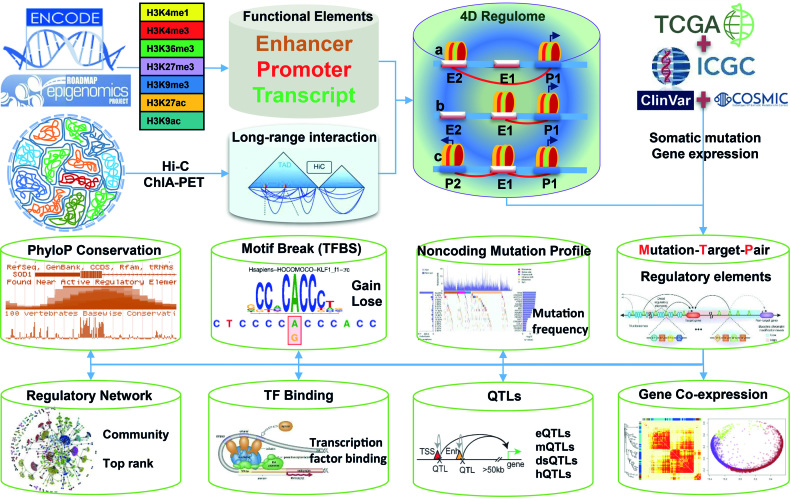
Workflow of OncoBase construction.